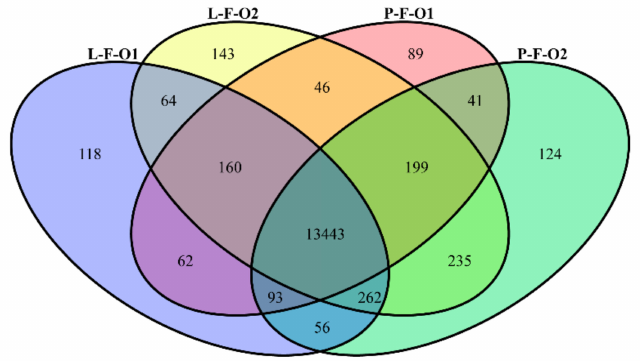
Figure 1. Numbers of expressed genes. Genes expressed in four groups. P-F-O1, P-F-O2, L-F-O1,